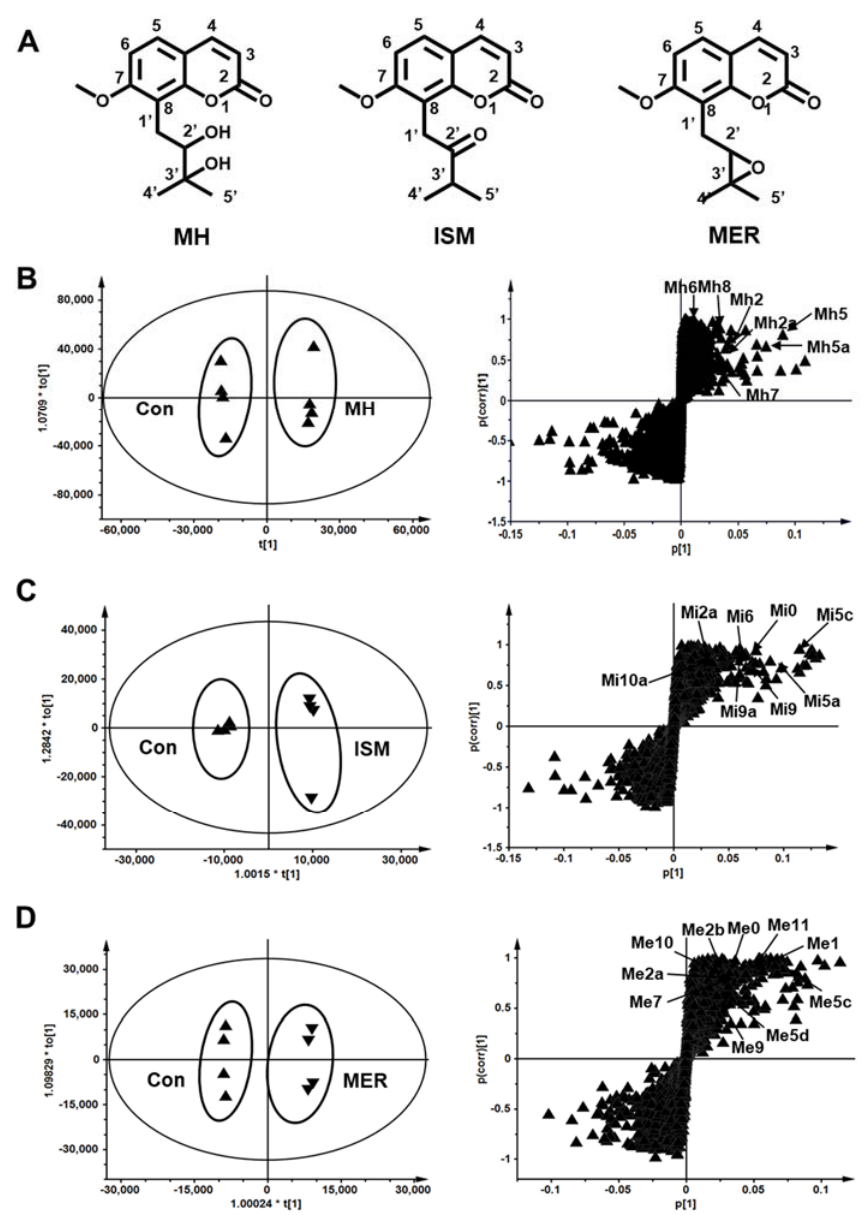
Figure 1. Structure of coumarins and metabolic profiling of MH, ISM, and MER in mice. ( A ) Meranzin hydrate (MH), isomeranzin (ISM), meranzin (MER). ( B ) Scores plot of OPLS-DA and S-plot analysis from control and MH-treated mice urine. ( C ) Scores plot of OPLS-DA and S-plot analysis from control and ISM-treated mice urine. ( D ) Scores plot of OPLS-DA and S-plot analysis from control and MER-treated mice urine.